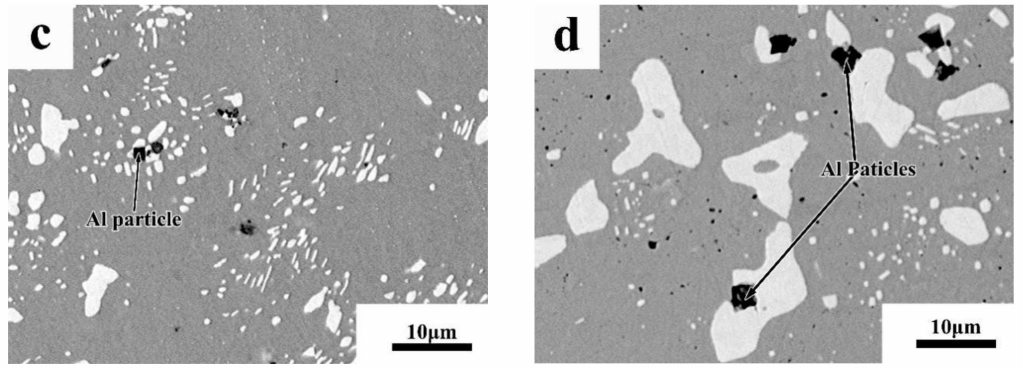
Figure 2. High-magnification SEM microstructures of Sn-20Bi-xAl Solder alloys: ( a ) Sn-20Bi,